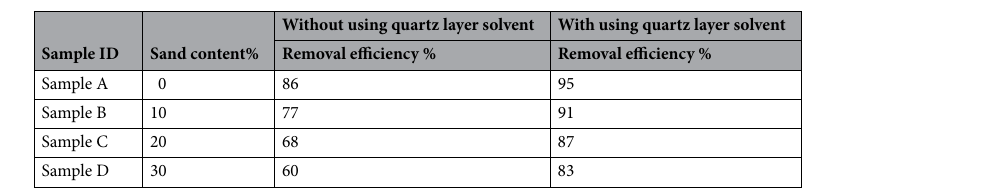
Figure 6. Schematic of filter cake consist of two layers (polymeric layer, fine cuttings accumulated in filter cake (quartz layer Si + ), and weighting material). The removal process ( a ) breaks the polymer coated layer and quartz layer (thermochemical solution) and ( b ) dissolves the main filter cake layer (weighting material).